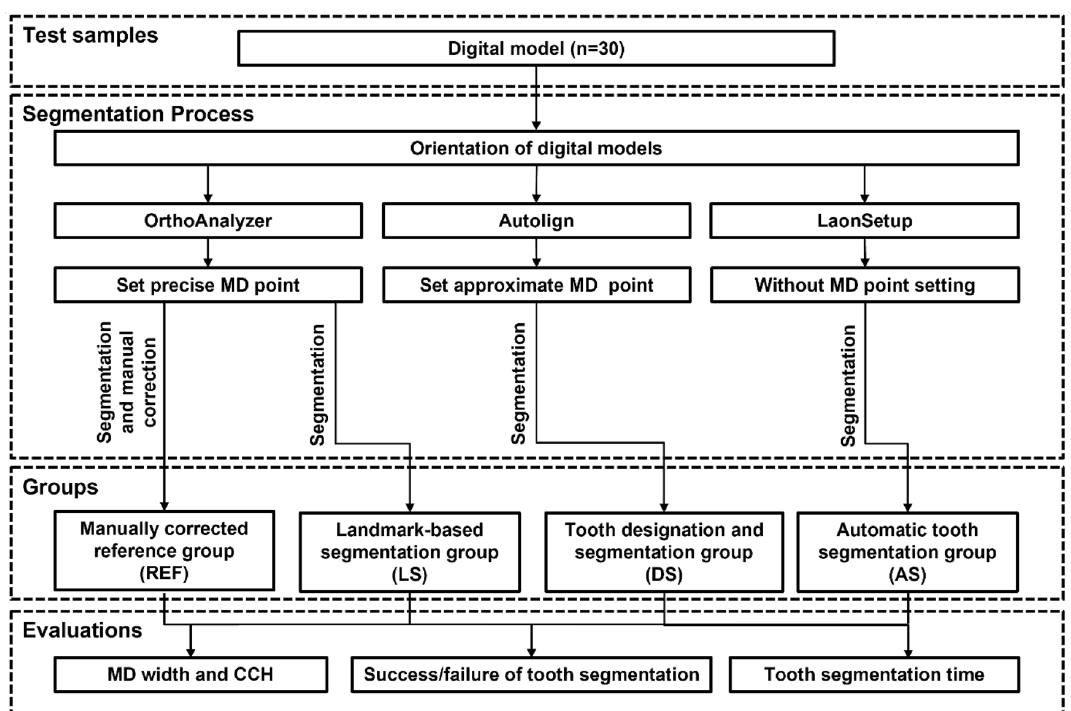
Figure 2. Schematic diagram indicating the study flow. Thirty digital dental models were segmented using three types of software (i.e., OrthoAnalyzer, Autolign, and LaonSetup). The manually corrected segmented tooth was used as the reference group. The size of the segmented teeth such as MD width and CCH, success and failure of tooth segmentation, and tooth segmentation time were